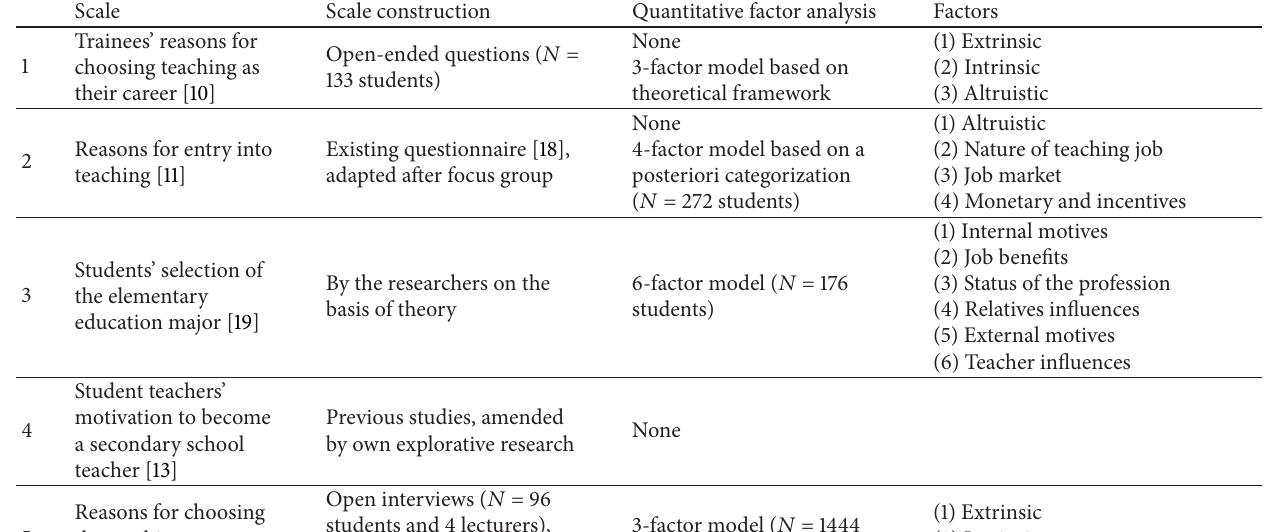
Table 1: Overview of studies on measurement of motivation for entering the teaching